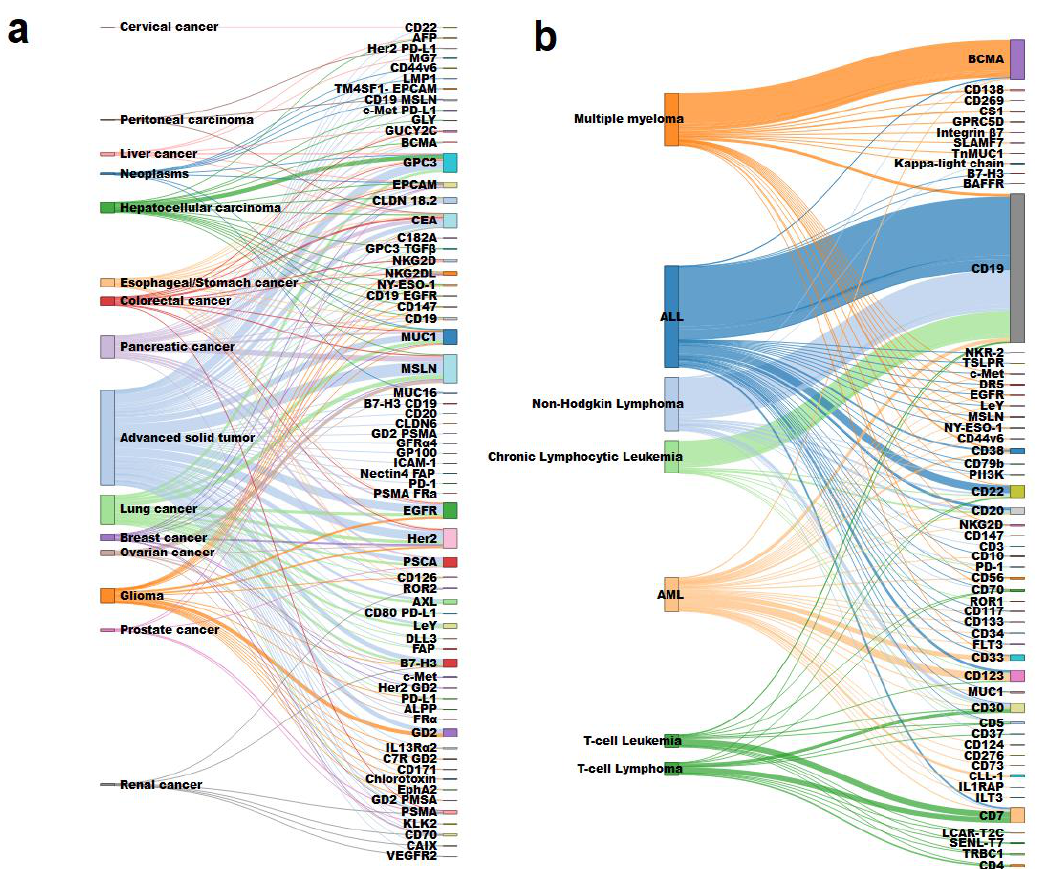
Figure 4. Disease and target antigen combination for CAR-T cell clinical trials. ( a ) Solid tumors are depicted on the left and the target on their right. The term “Advanced solid tumors” was attributed when the malignancy was not described in the trial. ( b ) Hematologic malignancies and the corresponding targets used in CAR-T cell trials. The line colors are according to the tumors, each line representing one study. The bar thickness is according to the number of studies of tumor or target.